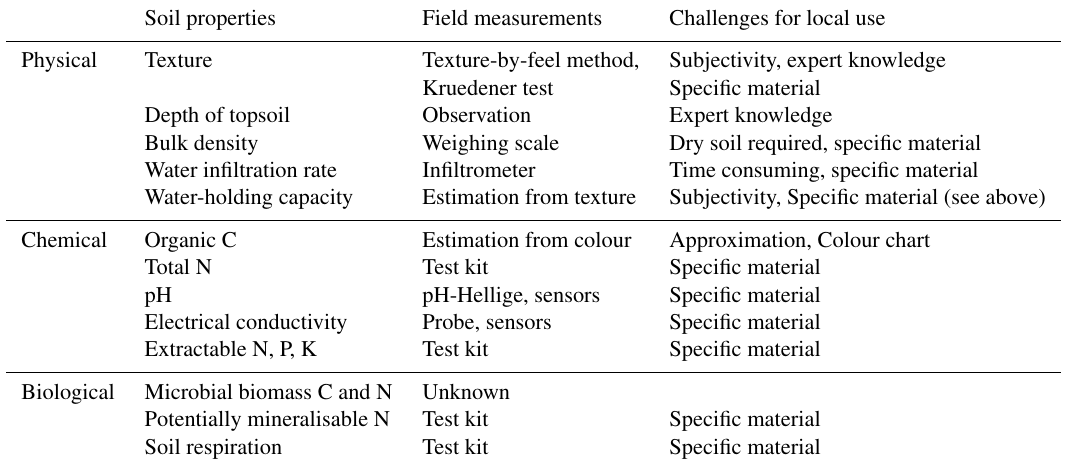
Figure 1. Overview of southern Africa and satellite view (GoogleEarth; with enhanced colour saturation) of north-central Namibia with the Cuvelai floodplain (northwest), the Kalahari Sandveld (northeast) and location of the three study areas (Omhedi, Ondobe, and Ekolola). Vegetation appears in green, bare soil appears in orange, water bodies in blue (Digital Atlas of Namibia). Table 1. Frequently used soil properties that may be used as field soil quality (SQ) indicators, possible field measurements techniques and challenges for local users (adapted from Wienhold et al.,